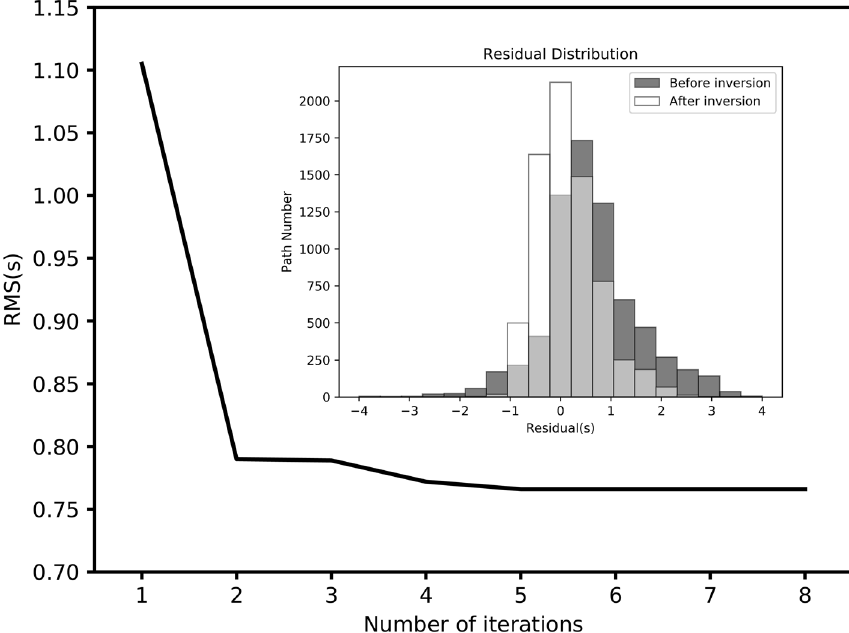
Figure 7. Variation of the RMS value of surface-wave travel-time residuals through the iterations. The inset shows the histograms of travel-time residuals before (in gray) and after inversion (in